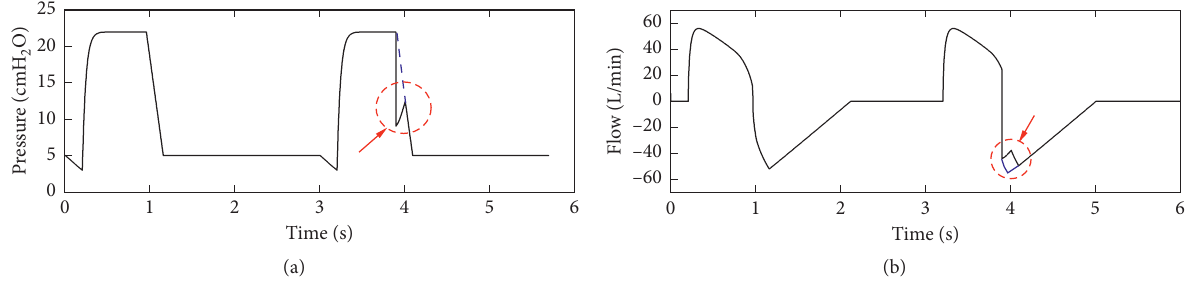
Figure 11: Ventilator waveforms of premature